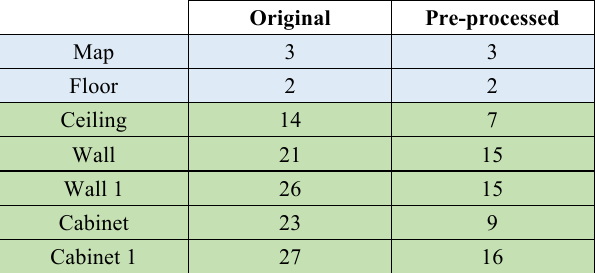
Table 4. Plane fitting RMSEs